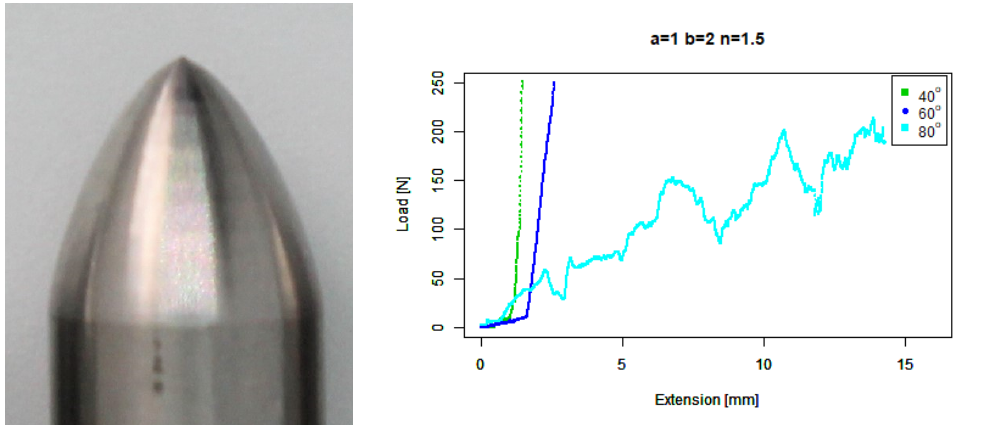
Figure 12. Extruded convex tip. ( Left ) Tip Profile. ( Right ) Experimental characterisation.